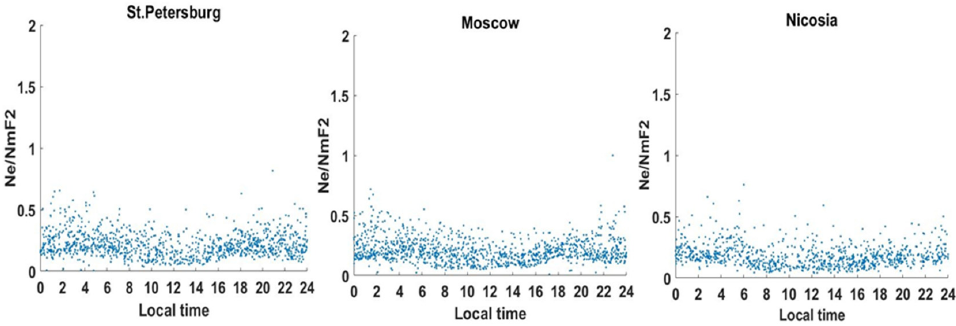
Figure 6. Local time variation in Ne/NmF2 of COSMIC-1 electron density (Ne) at Swarm B altitude (505 km) to COSMIC-1 peak electron density (NmF2) over St. Petersburg, Moscow and Nicosia for 2007–2018.